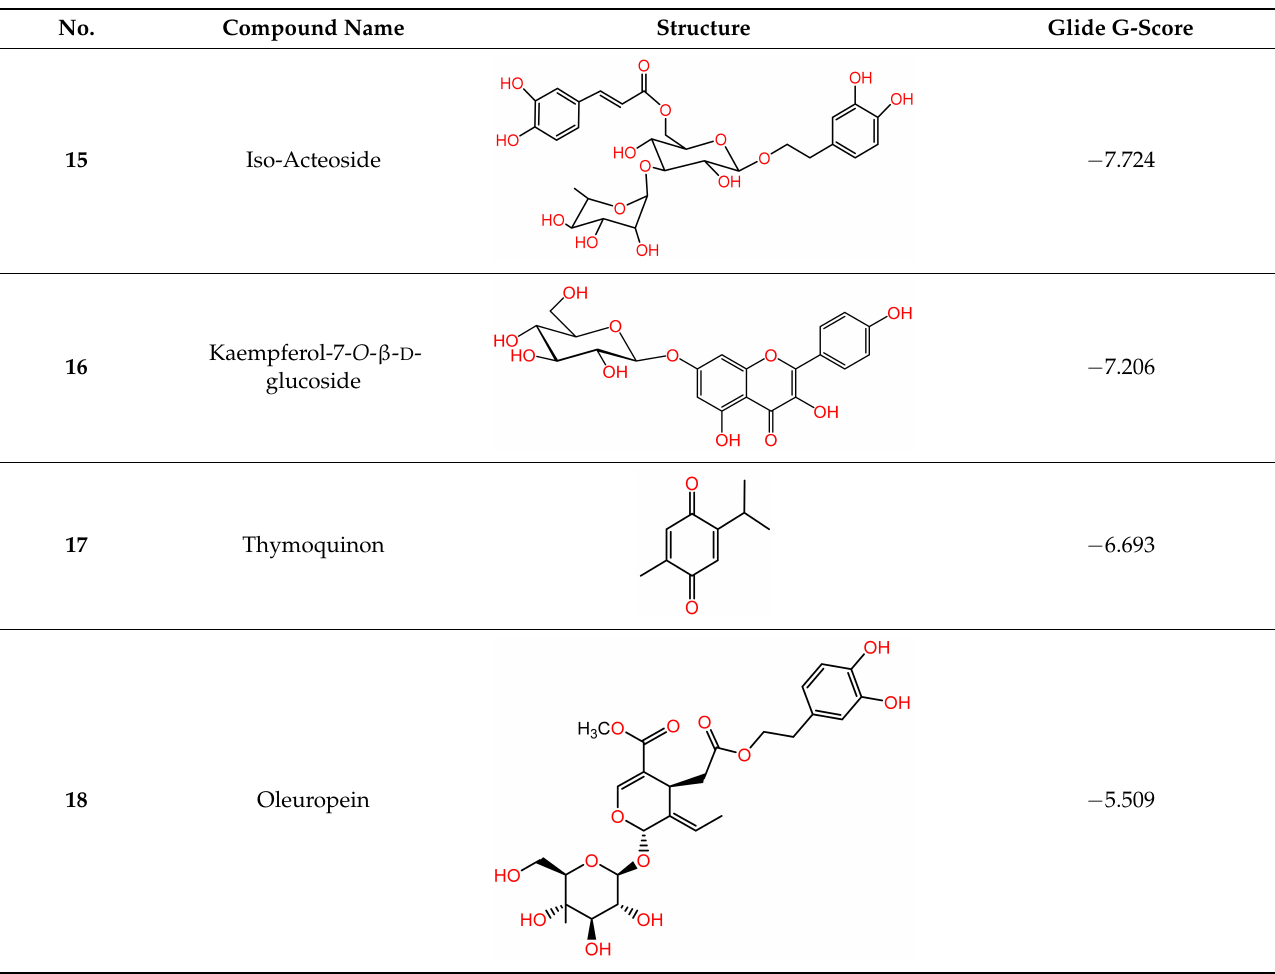
2.2. Results of In-Vitro Inhibition of SARS-CoV-2 M PRO by Selected Natural Product Isolates Screening of the top hit compounds towards SARS-CoV-2 M PRO was performed utilizing the FRET assay and the known inhibitor GC376 as positive control. The results revealed that naringenin, 2,3 (cid:48) ,4,5 (cid:48) ,6-pentahydroxybenzophenone, apigenin-7- O -glucoside, sennoside B, and acteoside are the most potent inhibitors, with ≥ 75% inhibition of enzyme (Figure 1). On the other hand, ochnaflavonone-4 (cid:48) -methyl ether and thymoquinone showed moderate activities with 53% and 63% inhibition, respectively, at 100 µ M concentration. The IC 50 values of the most potent inhibitors were 102, 104, 92, 74 and 43 nM, respec- tively, compared to 44 nM of the positive control (Table 2, Figure 2). The results of both docking study and in vitro enzyme inhibition assay were in good agreement in most cases with some exceptions as follows; the most active compounds in docking study showed the most potent enzyme inhibition effects except in case of ochnaflavonone-4 (cid:48) -methyl ether which showed lower activity despite its promising docking score. On the other hand, all the compounds with docking score lower than that of apigenin-7-O-B-D glucoside did not show any significant enzyme inhibitory effect except for thymoquinone which showed moderate